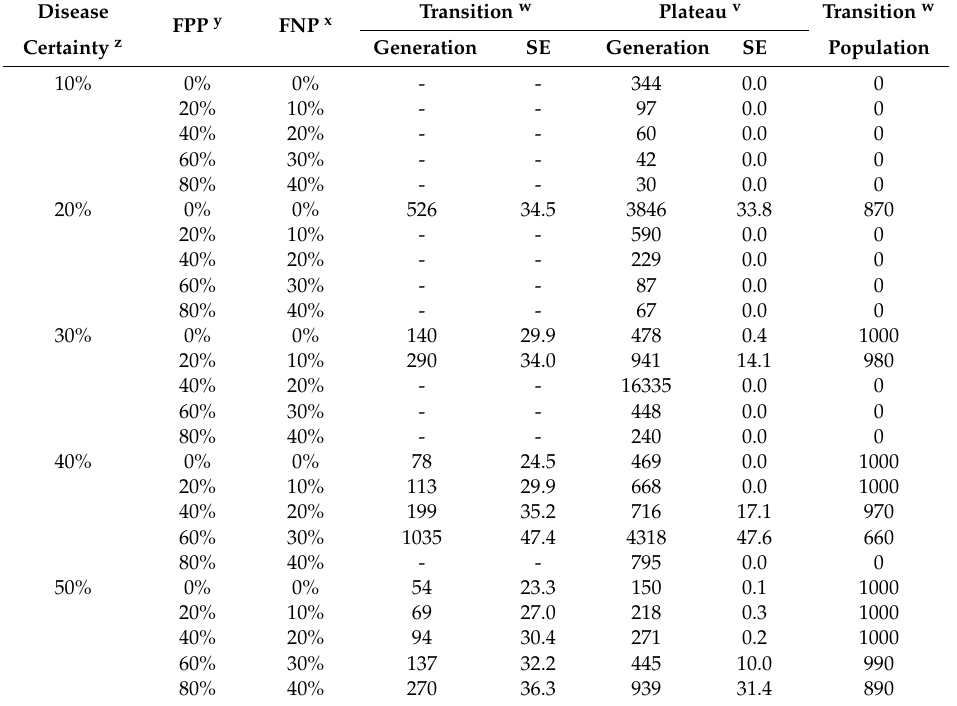
Table 2. Meta-analysis of fitness costs or benefits of salicylic acid-mediated induced resistance to chemical or biological inducers in various plant species in presence or absence of pathogen